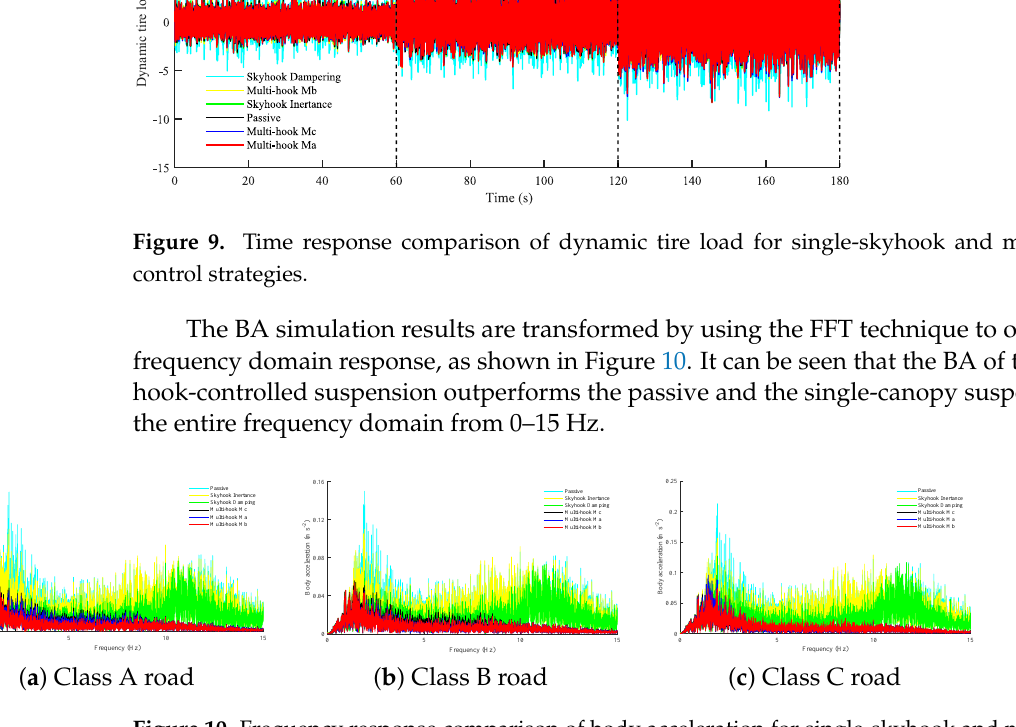
Figure 10. Frequency response comparison of body acceleration for single-skyhook and multi-hook control strategies.